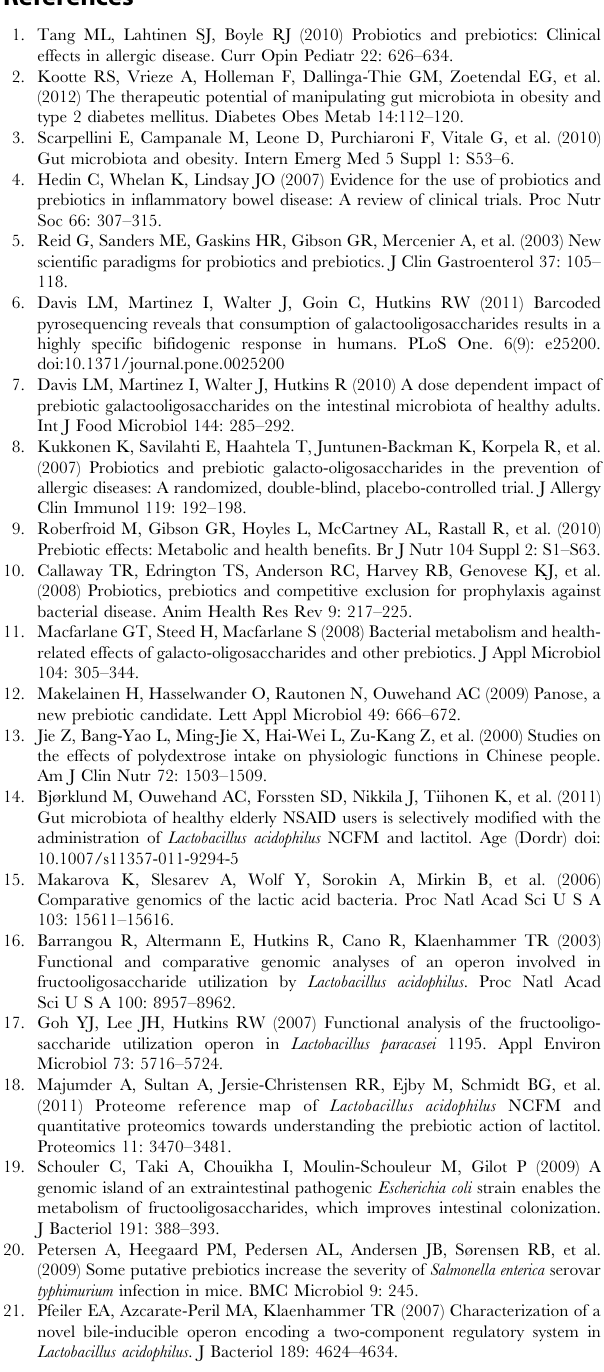
Table S1 Primers used for construction of gene deletion mutants. Restriction sites are highlighted in bold and